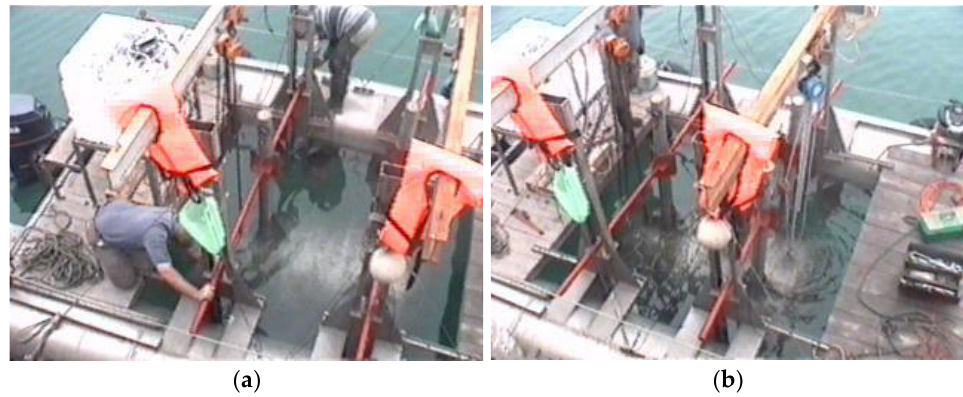
Figure 7. The duct scale models D3 ( a ) and D4 ( b ) fixation at the lower level with the highest part about 0.5 m below the water surface.